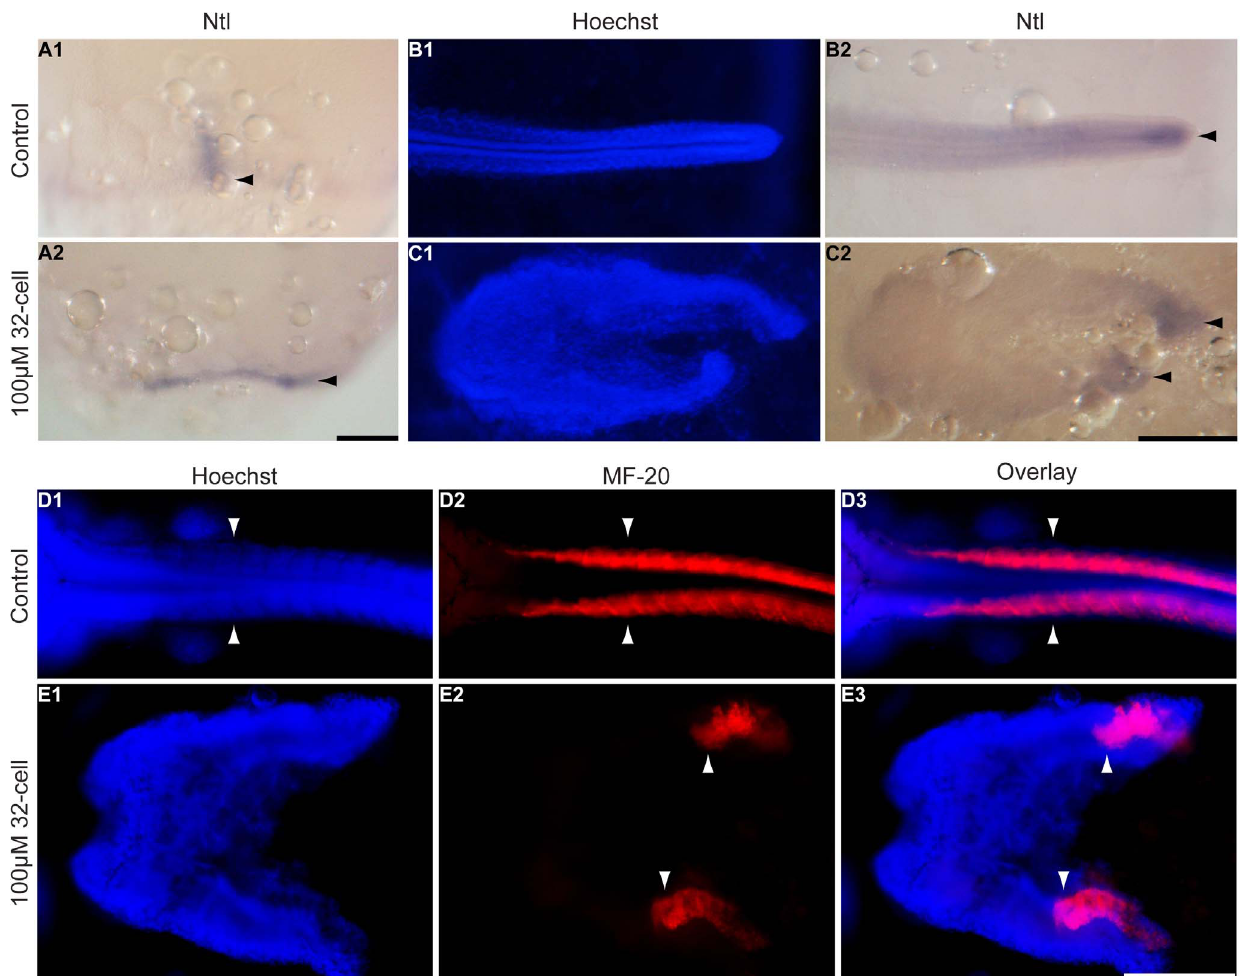
Figure 4. Somites and the notochord are divided in the splitbody phenotype. K. marmoratus embryos were exposed to 100 m M dorsomorphin at the 32-cell stage and fixed 1 and 4 days post-fertilization in order to stain the notochord by in situ hybridization using a medaka ntl probe ( A, B , C ), and somites using the myosin antibody MF-20 ( D , E ). In control embryos at late gastrula, ntl stained axial mesoderm in the dorsal axis ( A1 arrowhead, n=10/10), whereas in DM treated embryos these cells appeared to have stayed in the lateral domains ( A2 arrowhead, n=10). At day 4, ntl stained the notochord in the tip of the tail for control embryos ( B2 arrowhead, n=10/10), whereas splitbody embryos had the tips of both body axes stained with ntl ( C2 arrowheads, n=10/10). For control embryos, somites are formed as pairs arranged either side of the neural axis ( D1–3 arrowheads, n=10/10). In the splitbody phenotype, somites were unpaired and separated in the two body axes ( E1 Hoechst staining showing the body split; E2, 3 arrowheads, somites are present in both axes, n=10/10). Photographs were taken at late gastrula for A , and 4 days post-fertilization for B – E . Images in A are lateral views and for B – E dorsal views of the embryos. Scale bars: 250 m m.